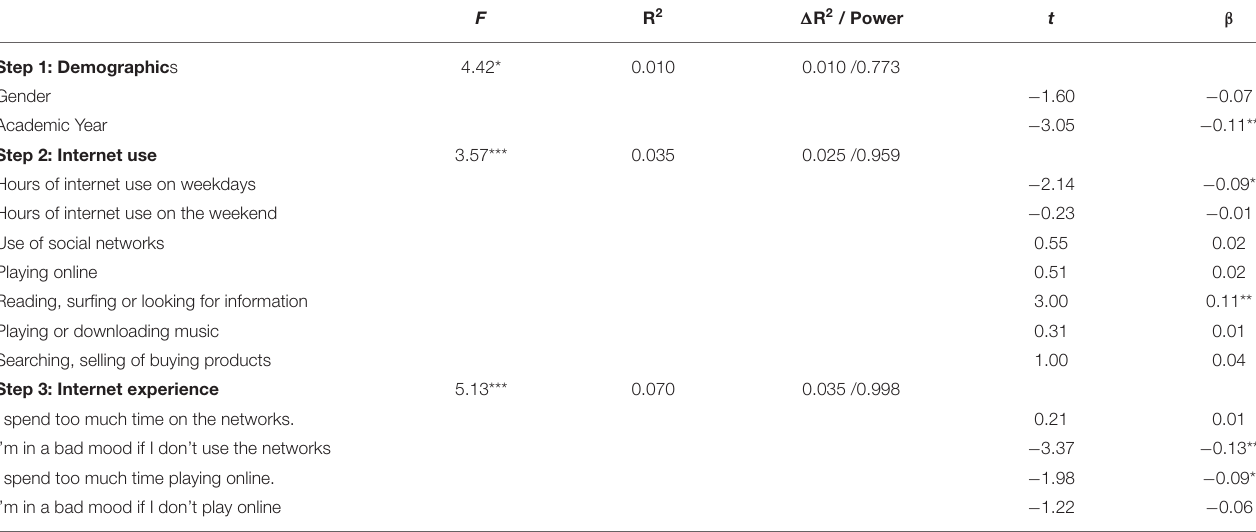
TABLE 4 | Hierarchical regression analysis of the effects by demographics, variables of Internet use, and Internet experience on PYD. F R